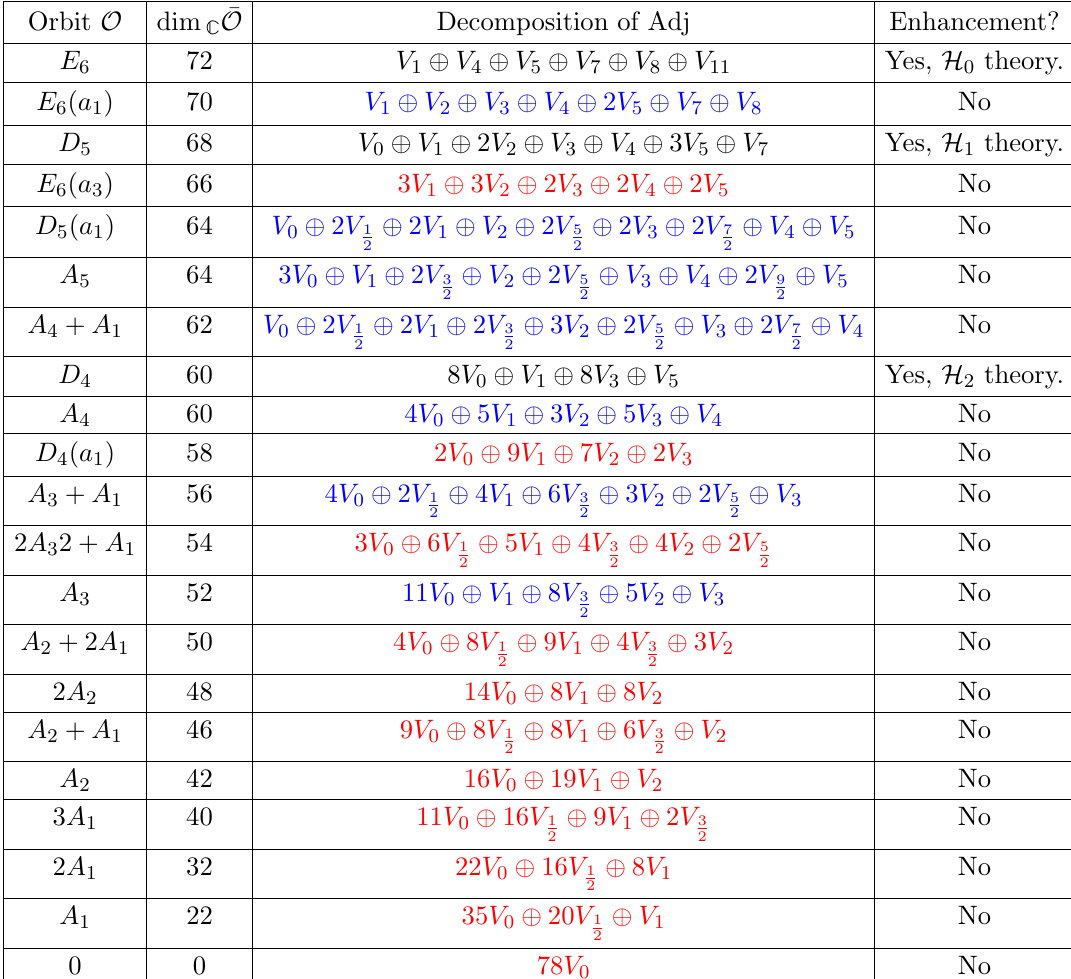
Table 3 . All the nilpotent orbits of e 6 and their adjoint decomposition. Table taken from [56].